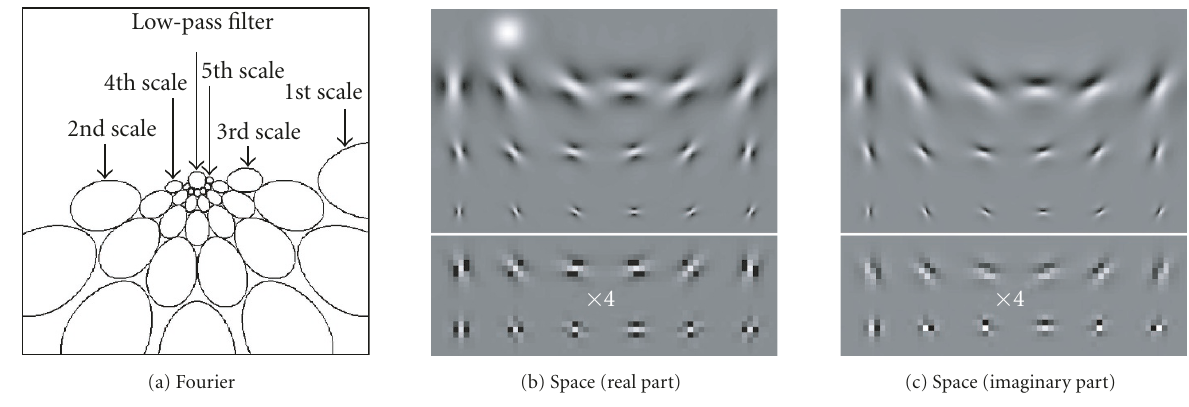
Figure 3: Multiresolution scheme with 6 orientations and 5 scales. (a) Schematic contours of the filters in the Fourier domain. The Fourier domain origin (DC component) is located at the center of the inset and the highest frequencies lie on the border. (b) Real part of the filters in the space domain. Scales are arranged in rows and orientations in columns. The two first scales are drawn at the bottom magnified by a factor of 4 for a better visualization. The low-pass filter is drawn in the upper-left part. (c) The imaginary part of the filters is shown in the same arrangement. The low-pass filter does not have an imaginary